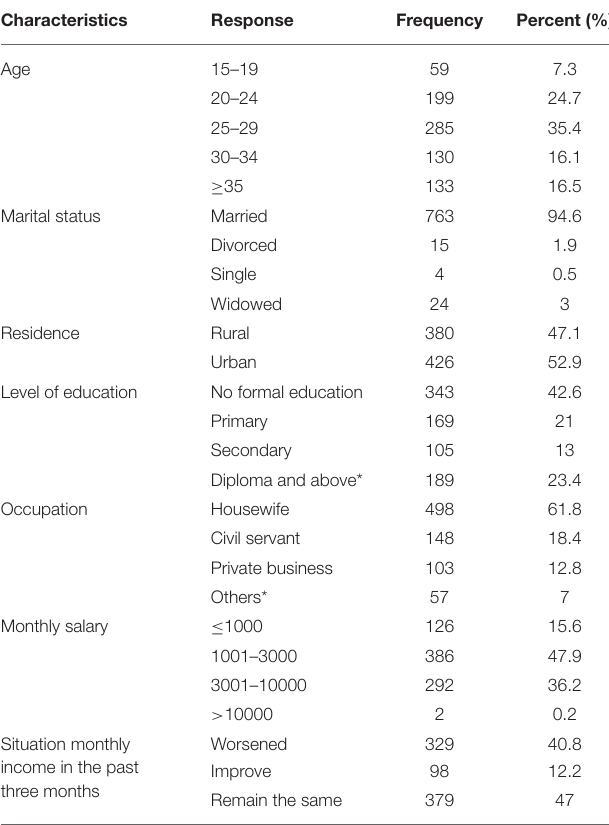
TABLE 1 | Socio-demographic characteristics of pregnant women attending ANC during COVID-19 pandemic at public health facilities of East Gojjam zone, Amhara region, Ethiopia, 2020. ( n =